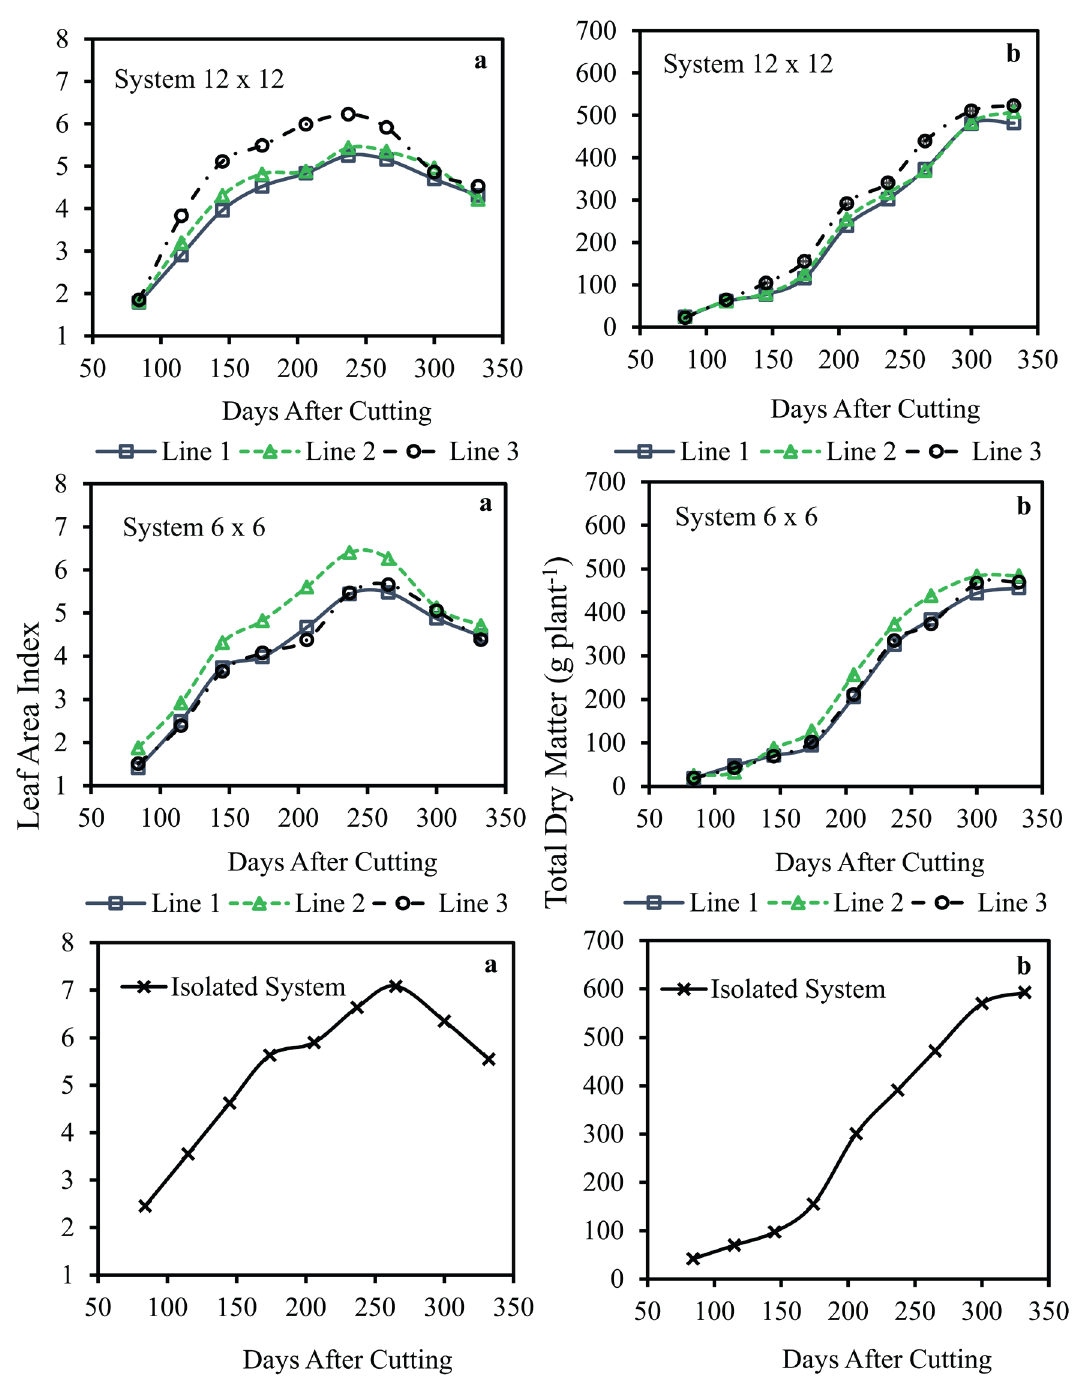
Figure 4 - Leaf area index ( a ) and total dry matter ( b ) of sugarcane in agroforestry and isolated systems in different lines of evaluation throughout the days after